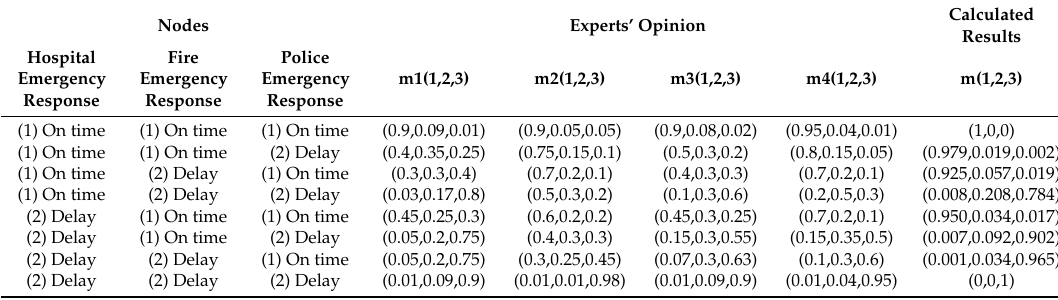
Table 2. Partial probability questionnaires and weighted conditional probabilities of BN nodes.